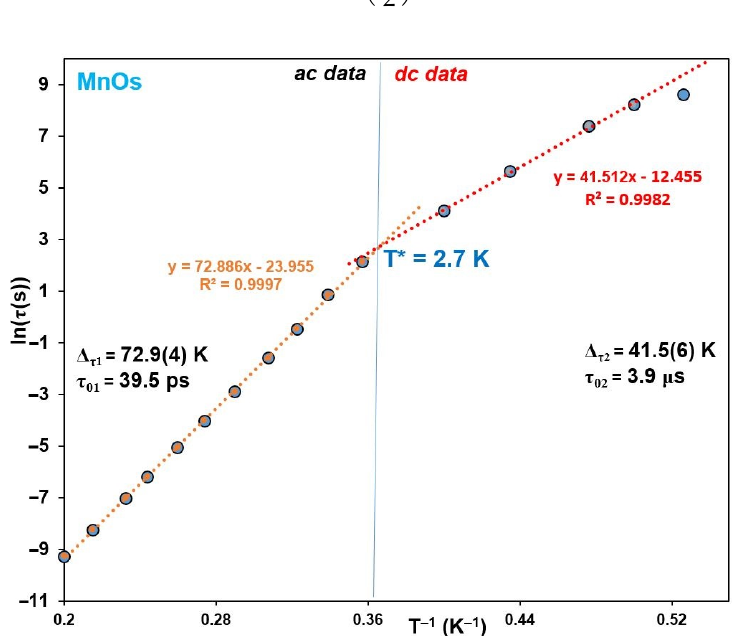
Figure 8. Relaxation time of 1 derived from the ac data (left) and time dependent dc magnetization (right). The dotted lines correspond to the fit according to the Arrhenius law: τ = τ 01 ∙ exp ( Δ τ 1 /k B T) . T* represents a crossover temperature.